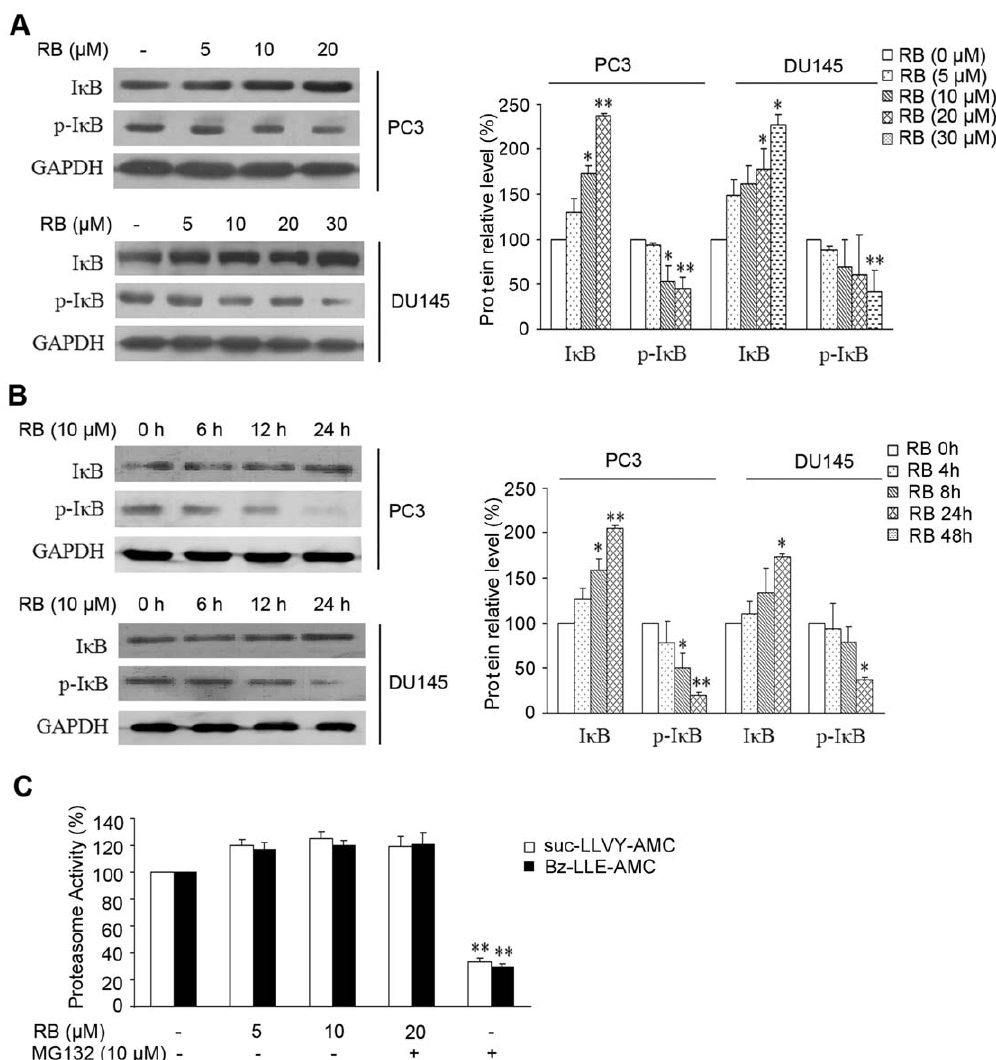
Figure 3. RB inhibits phosphorylation and degradation of I k B a . (A) Western blot analysis of expression of total I k B a and phosphor-I k B a ( p– I k B a , Ser32/36)p-I k B a . PC3 and DU145 cells were treated with RB of different doses as indicated. (B) Western blot analysis of expression of total I k B a and p-I k B a . PC3 and DU145 cells were treated with RB of different times as indicated. In (A) and (B), equal protein loading was evaluated by GAPDH. Protein amount was normalized to the amount of GAPDH, and was quantified by densitometry of X-ray films. Results of one of at least three independent experiments are shown. (C) The effect of RB on the purified 20S proteasome in vitro . MG132 served as positive control. Results are the mean 6 SD of three independent experiments, p , 0.05 (*), p , 0.01 (**), versus untreated control group